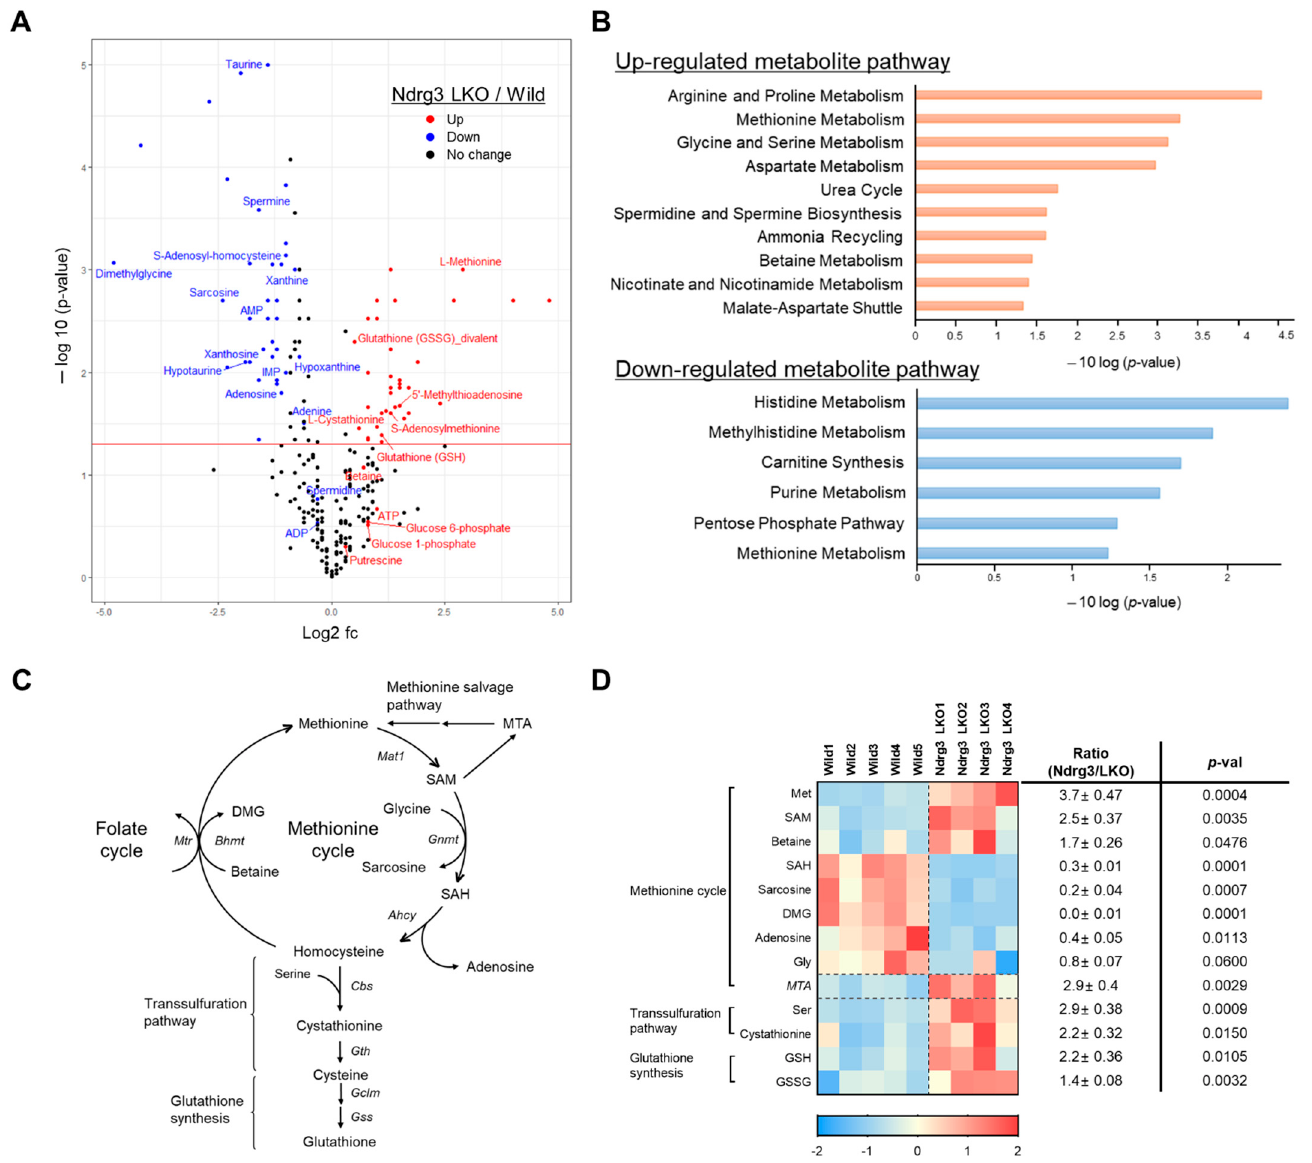
Figure 6. Perturbation of methionine metabolism caused by NDRG3 ablation in mouse hepatocytes. ( A ) A volcano plot for identifying differentially expressed metabolites between wild-type ( n = 5) and Ndrg3 LKO mouse livers ( n = 4). Blue dots with ( p < 0.05, log 2 (fold change) < − 1) indicate metabolites significantly downregulated in Ndrg3 LKO livers compared to wild-type, whereas red dots with ( p < 0.05, log 2 (fold change) > 1) represent metabolites significantly upregulated in Ndrg3 LKO livers. Mice at 10–12 weeks of age were sacrificed under ad libitum states and used in the metabolome analysis. ( B ) Metabolome sets enriched in the livers of Ndrg3 LKO mouse relative to wild-type analyzed by MetaboAnalyst 5.0. Total of 68 metabolites satisfying ( p < 0.05, log 2 (fold change) > 1) between Ndrg3 LKO and wild-type were subject to the enrichment analysis, and the metabolome sets with p < 0.05 are shown. Red and blue, up- and down-regulated in Ndrg3 LKO livers relative to wild-type, respectively. ( C ) A schematic diagram representing the methionine cycle and its branch pathways. ( D ) Heatmap and relative ratios for the expression of metabolites of the methionine cycle and its branch pathways in the livers of wild-type ( n = 5) and Ndrg3 LKO ( n = 4) mice. Red, relatively upregulated. Blue, relatively downregulated. Data are presented as mean ± SEM. p -values were calculated using two-tailed Student’s t -test ( D ).